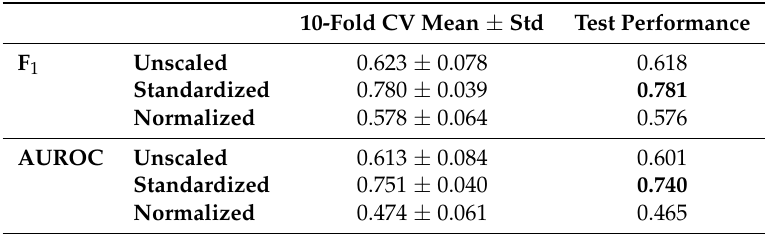
Table 4. Comparison of scaling methods, using a lagged response variable and a missingness count. The highest test performance is shown in bold.